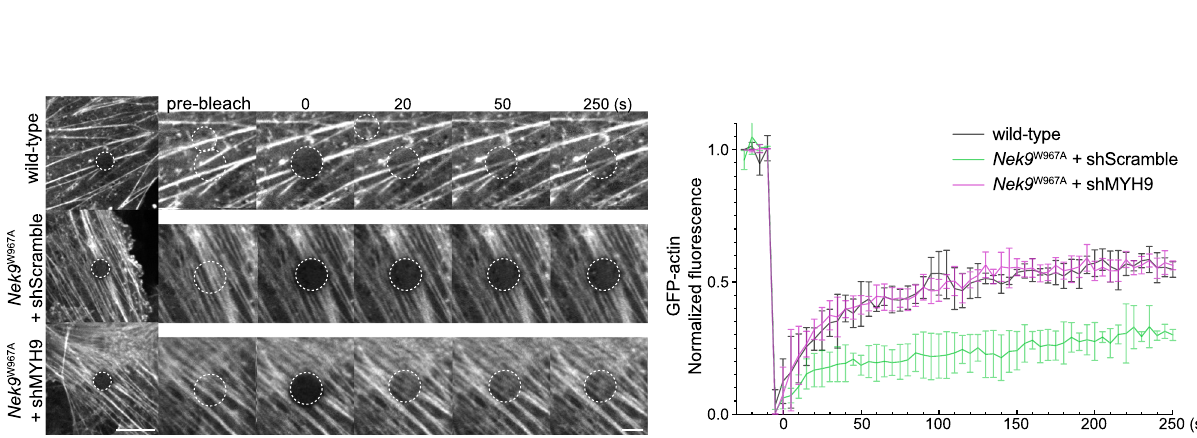
Fig. 7 Selective autophagy of MYH9 promotes ciliogenesis by increasing actin dynamics. FRAP analysis of GFP-actin in wild-type or Nek9 W967A MEFs after serum starvation (24 h). MYH9 was depleted by shRNA-mediated knockdown (#1). Images were recorded at 5-s intervals following photobleaching of the indicated area, and fl uorescence recovery at different time points was quanti fi ed. Data represent the mean ± SEM of 10 cells. Similar results were obtained using shMYH9 #2 (not shown). See Supplementary Fig. 6e, f for the knockdown ef fi ciency. Scale bars, 10 µ m and 3 µ m